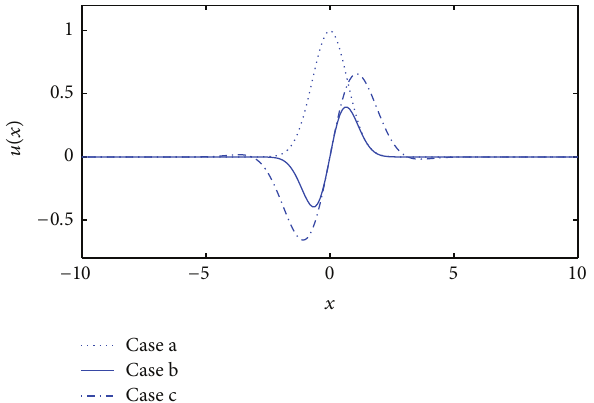
Figure 3: Exact solutions in Table 1.